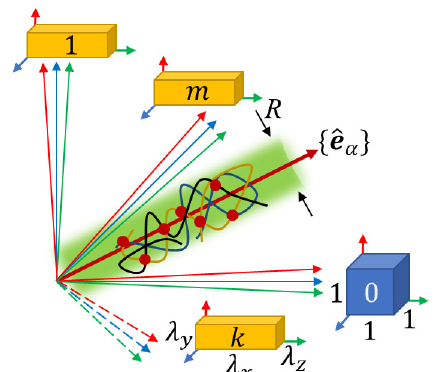
Figure 1. The replica system consists of the initial system ( k = 0)—the polymer network at preparation conditions (blue cube) and m identical replicas of the final system ( k = 1, . . . , m )—the network, deformed by factors λ α along the principal axes α = x , y , z of deformation (yellow cuboids). The polymer network in the replica space of dimension 3 ( 1 + m ) is mainly localized inside the (green) cylinder with the diameter R (cid:39) a ¯ N 1/2 directed along unit vectors { ˆe α } , corresponding to affine deformation of the polymer. The networks (and all their monomers and strands) in the initial system and any of the m replicas of the final system are the projections of the network in the replica space onto the corresponding subspaces k = 0, . . . , m